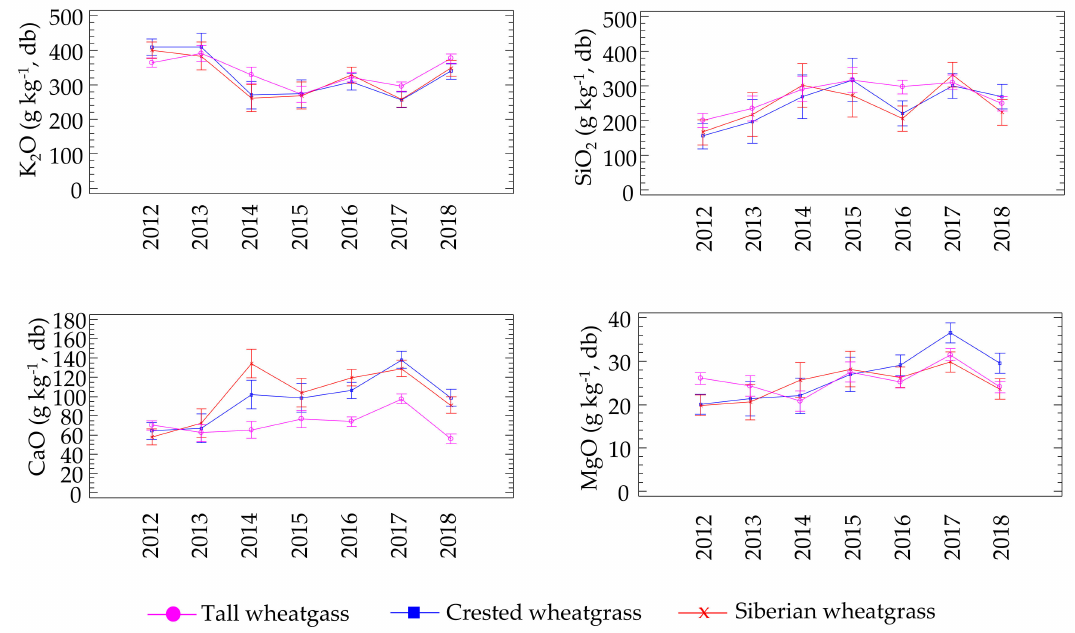
Figure 4. Si, K, Ca, and Mg variation across species and years for the biomass cultivated in CS fields (concentrations expressed as their corresponding oxides in the ash). Means and Fisher’s LSD interaction